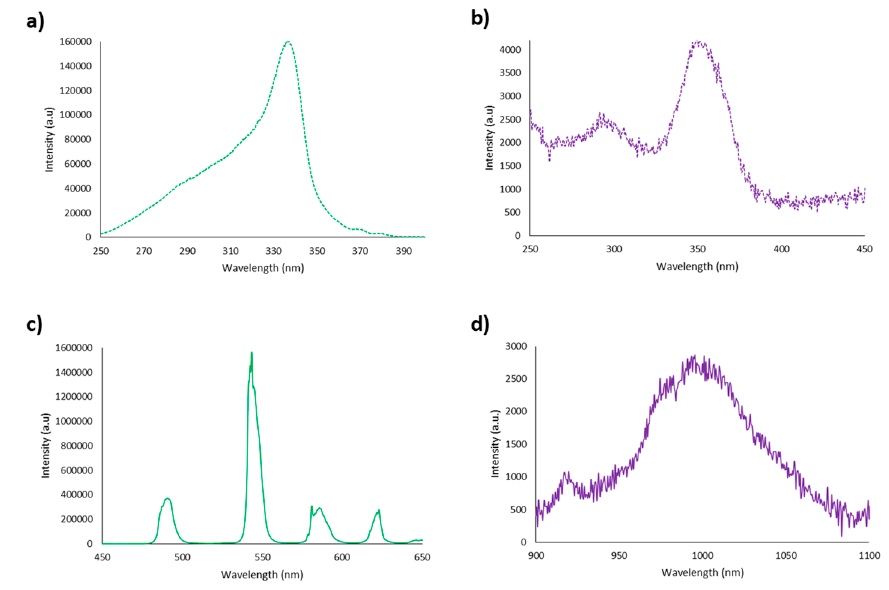
Figure 6. Luminescent behavior of Tb / Yb L 4 . Excitation spectra at ( a ) λ em = 545 nm ( b ) λ em = 980 nm. Emission spectra at λ exc = 338 nm ( c ) Tb(III) ( d ) Yb(III).